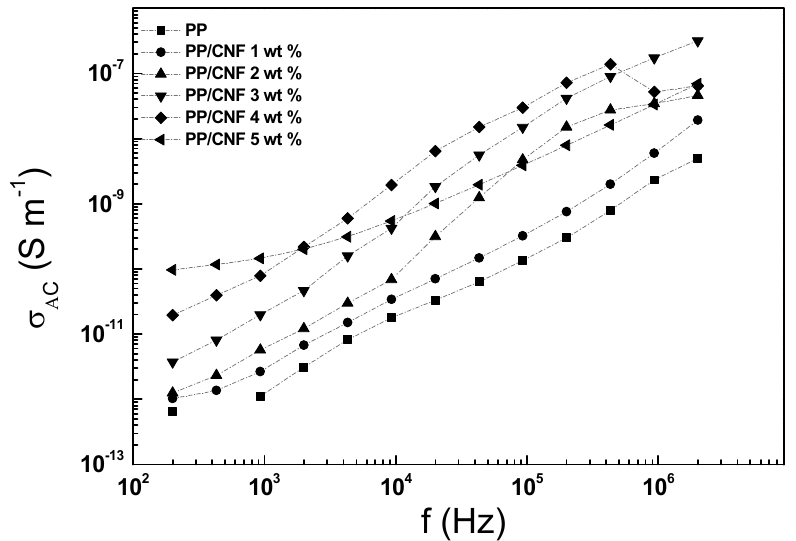
Figure 3. AC electrical conductivity of PP/CNF composites as a function of frequency (the dash-dot lines are to guide the eyes).